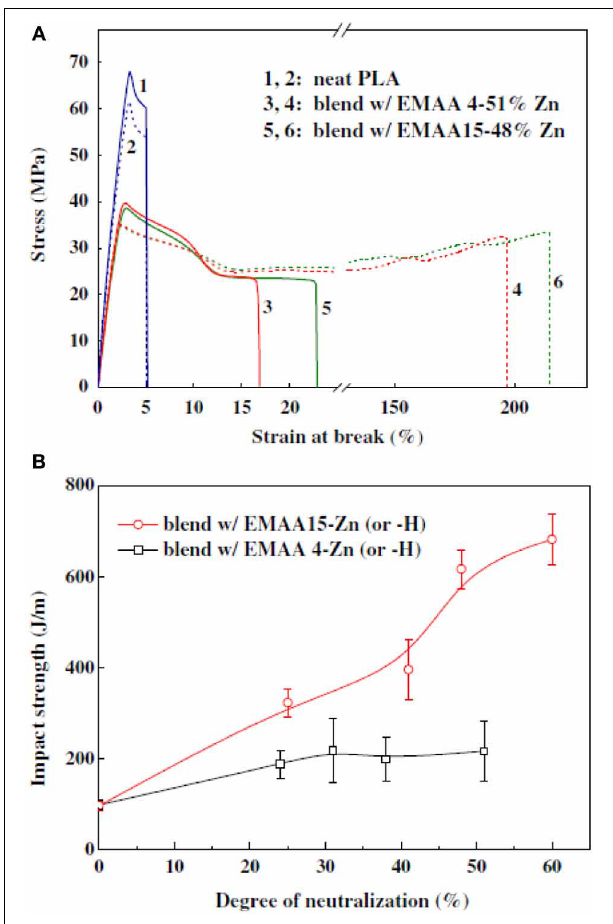
FIGURE 23 | (A) Tensile stress–strain curves of neat PLA and PLA/EBA-GMA/EMAA-Zn (80/15/5, w/w) ternary blends under speed of extension of 2 inch/min (solid line) and 0.2 inch/min (dash line), respectively. (B) Effects of degree of neutralization and functionality of ionomers on the IS of PLA/EBA-GMA/EMAA-Zn (or EMAA-H) (80/15/5, w/w) blends [Reprinted from Song et al. (2012) with permission from Elseiver].